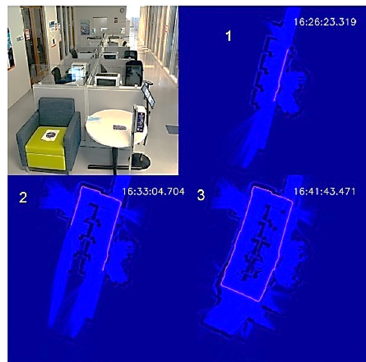
13 of 18 Figure 10. Functional prototype of the UVBot. To demonstrate the autonomous disinfection process, we tested the UVBot in two indoor environments: a corridor and an office, which cover most of the use cases. We